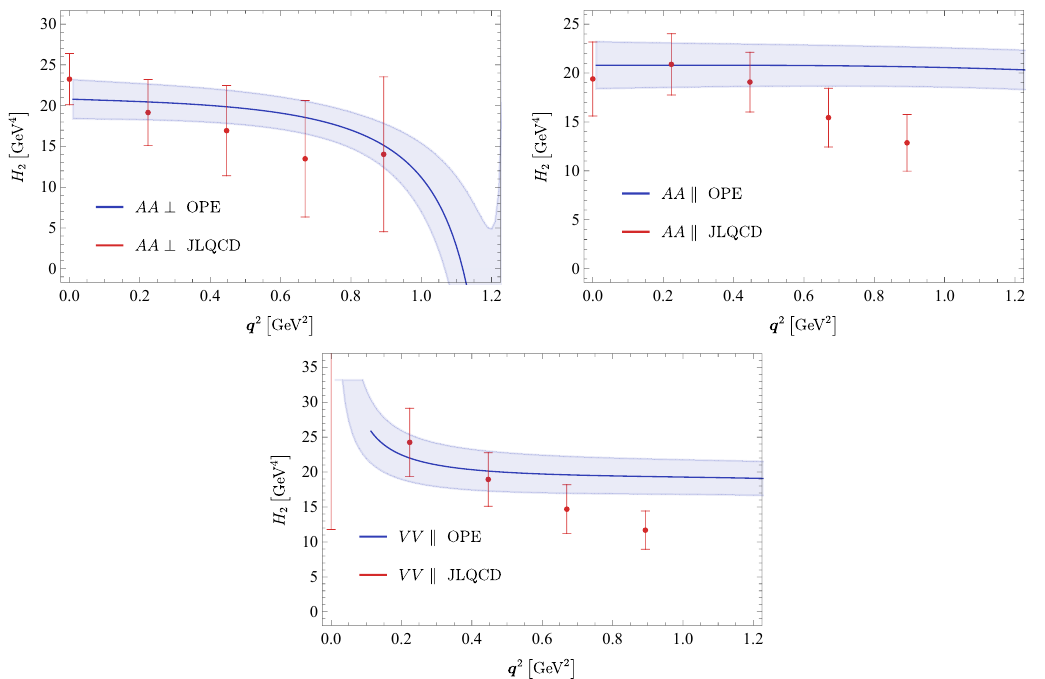
Figure 22 . Differential moment H 1 ( q 2 ) = h M 2 comparison between OPE and ETMC data.